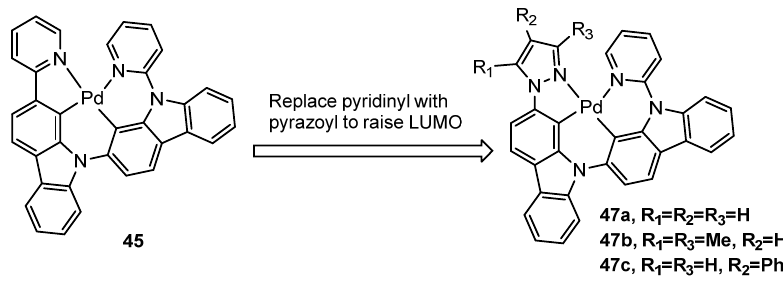
Figure 16. Modi fi cation of 45 for the building of blue MADF Pd(II) emi tt ers 47a − c . Adapted from Figure 16. Modification of 45 for the building of blue MADF Pd(II) emitters 47a–c . Adapted from [80].